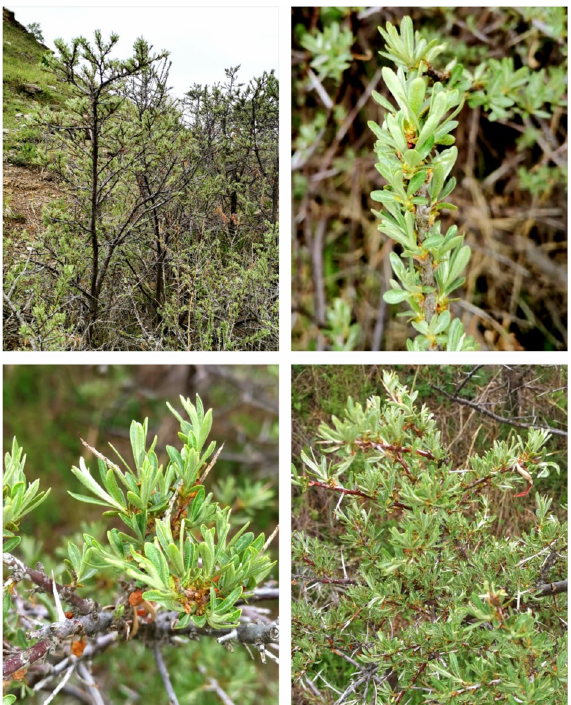
Figure 1. Representative Hippophae rhamnoides L. plants and their parts. Location—foothills of the Trans Ili Alatau Mountains (Almaty region, Kazakhstan). The plants were identified and voucher specimen No. 54 ( H. rhamnoides L.) was deposited at the herbarium of the Institute of Botany and Phytointroduction (Almaty,